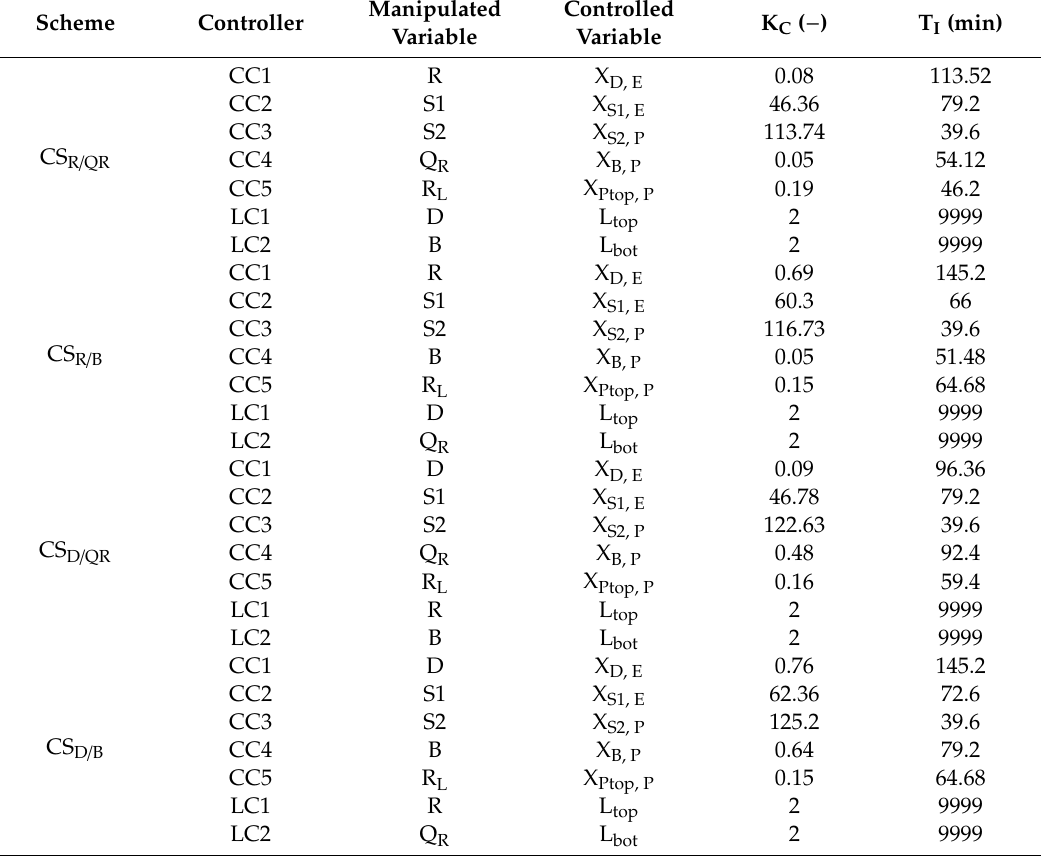
Table 2. Controller Parameters of the CS R / QR , CS R / B , CS D / QR , and CS D / B